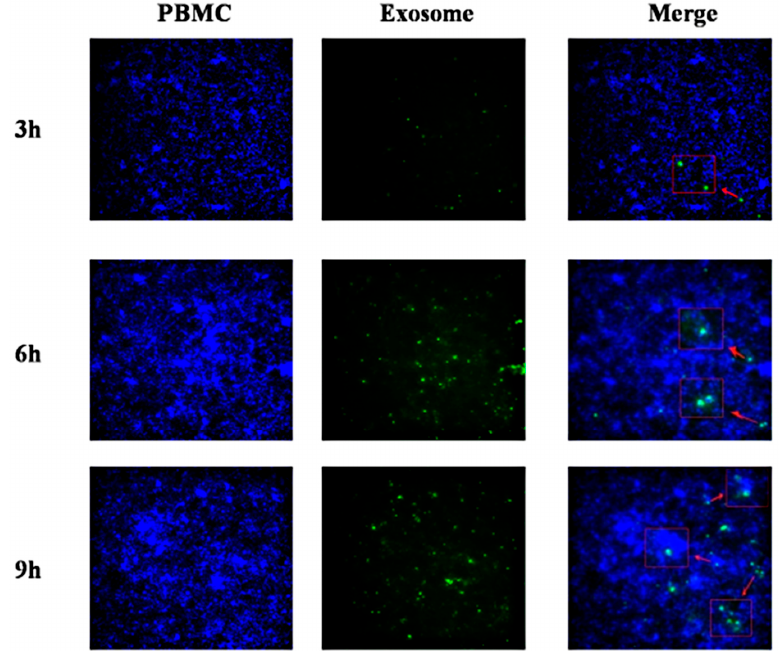
Figure 15. PBMCs ingest DEF-exosomes. To demonstrate that PBMCs could ingest exosomes secreted from DEF cells, we first stained exosome with PKH67 green fluorescent dye and co-cultured with PBMCs for 3, 6, and 9 h, and then the nucleus of PBMC were stained. Lately, we used fluorescence microscopy to detect the PBMC nucleus and exosomes respectively and then merged these pictures. From the merged pictures (200 µm), we can see that exosomes clustered around the nucleus of the PBMC, suggesting that exosomes were ingested by the PBMC.